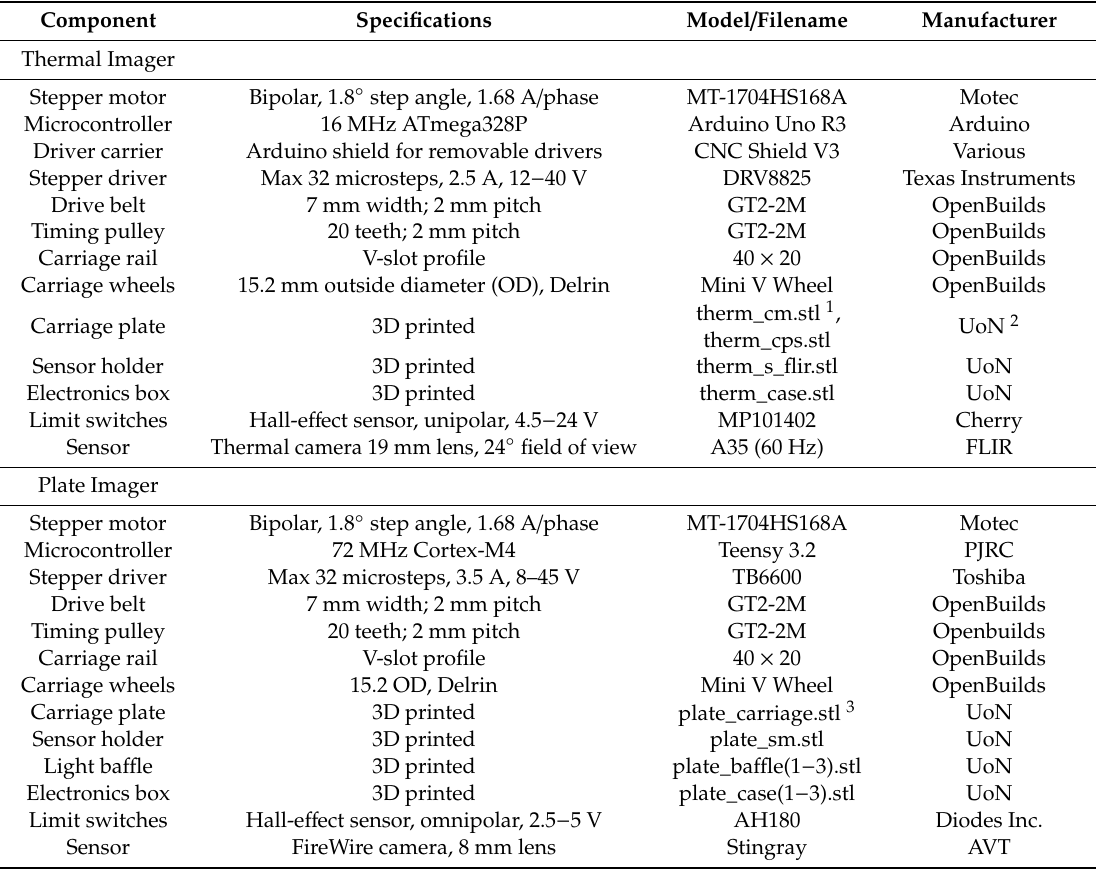
Table 1. Components for the automated plant phenotyping